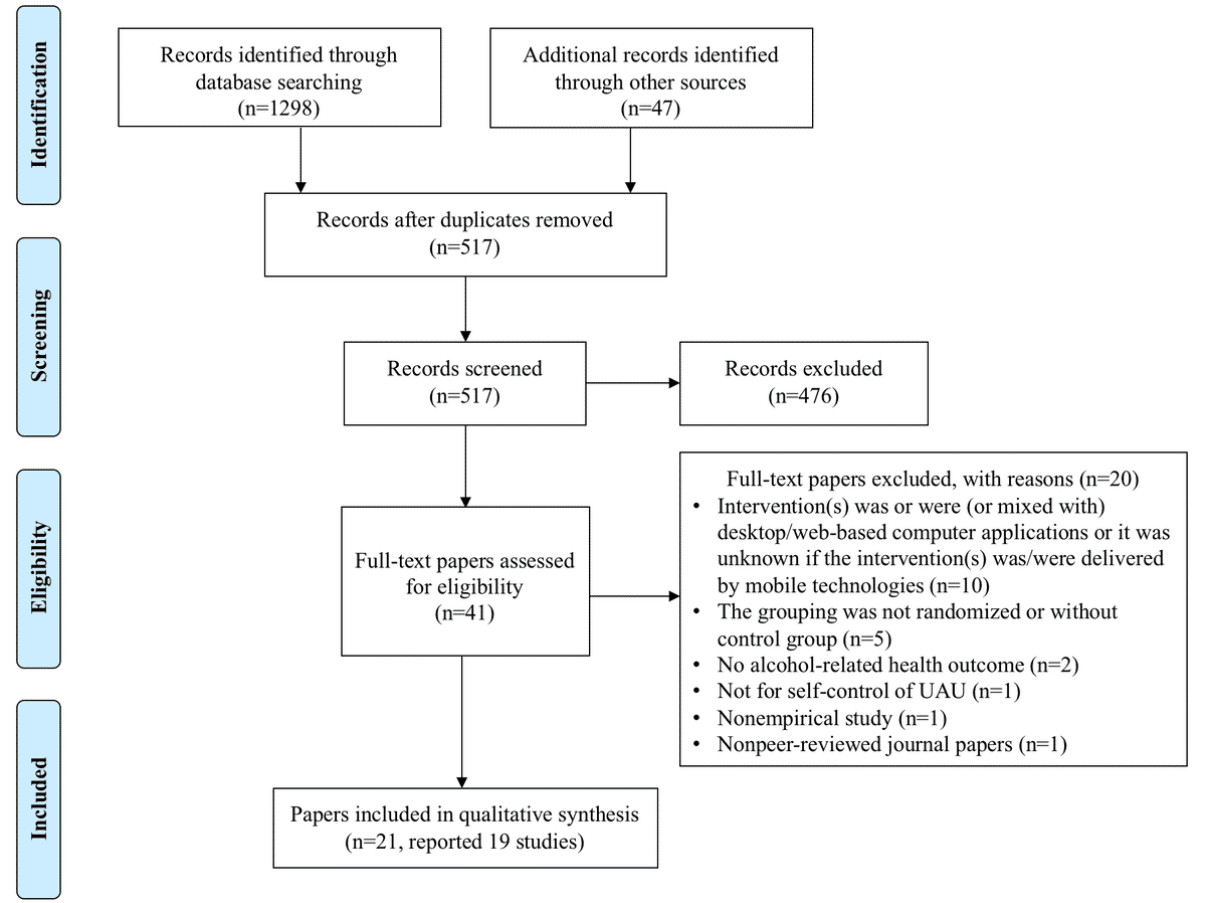
Figure 1. Literature search and screening